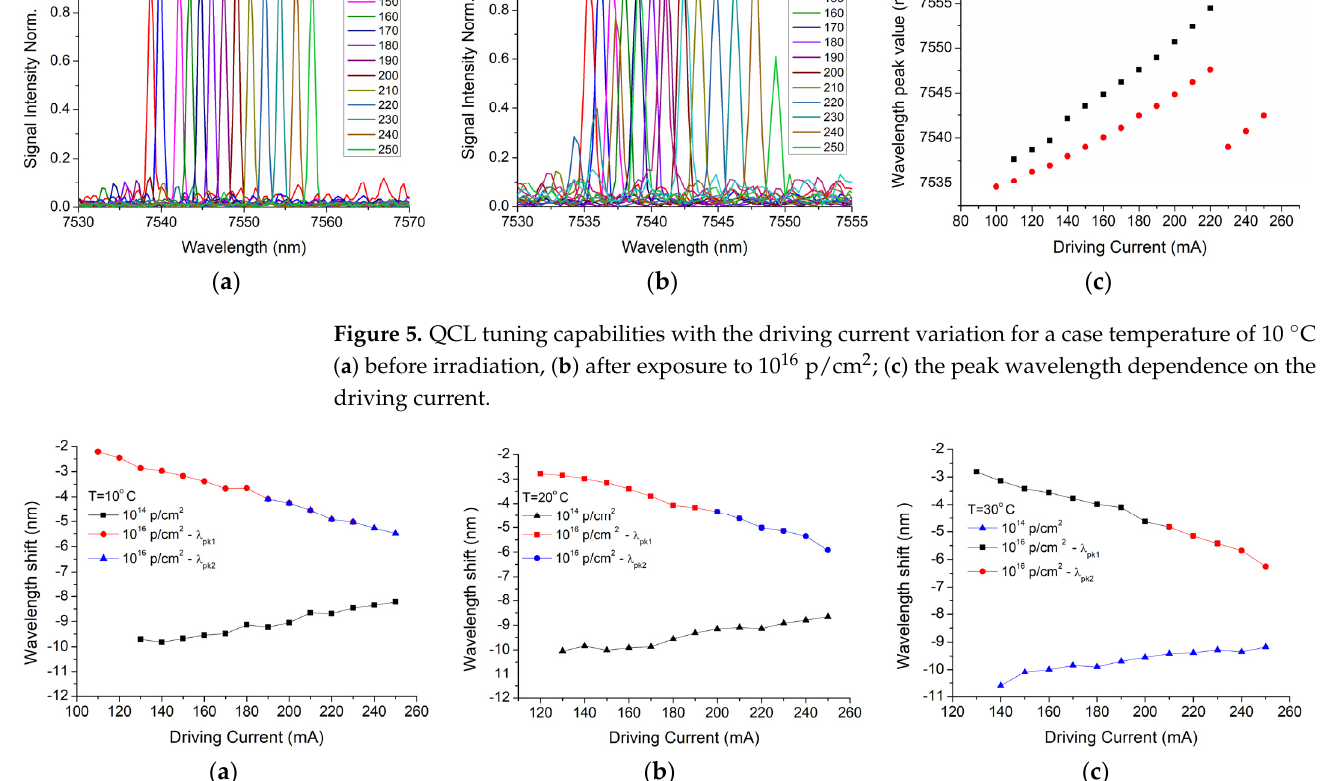
Figure 5. QCL tuning capabilities with the driving current variation for a case temperature of 10 °C ( a ) before irradiation, ( b ) after exposure to 10 16 p/cm 2 ; ( c ) the peak wavelength dependence on the driving current.